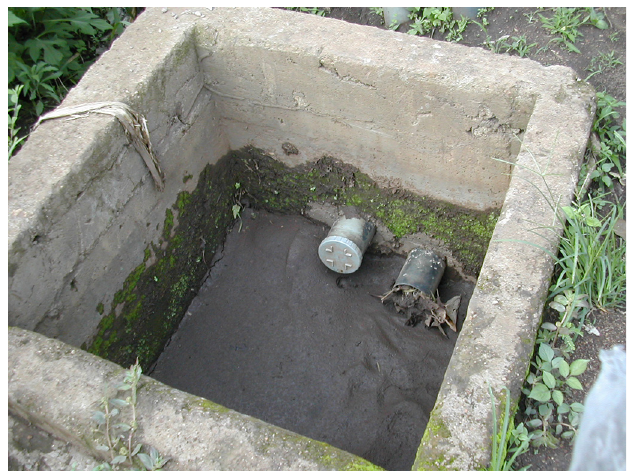
Fig. 3. Micro hydro plant at Firadou in Guinea (Photo J. Kenfack).